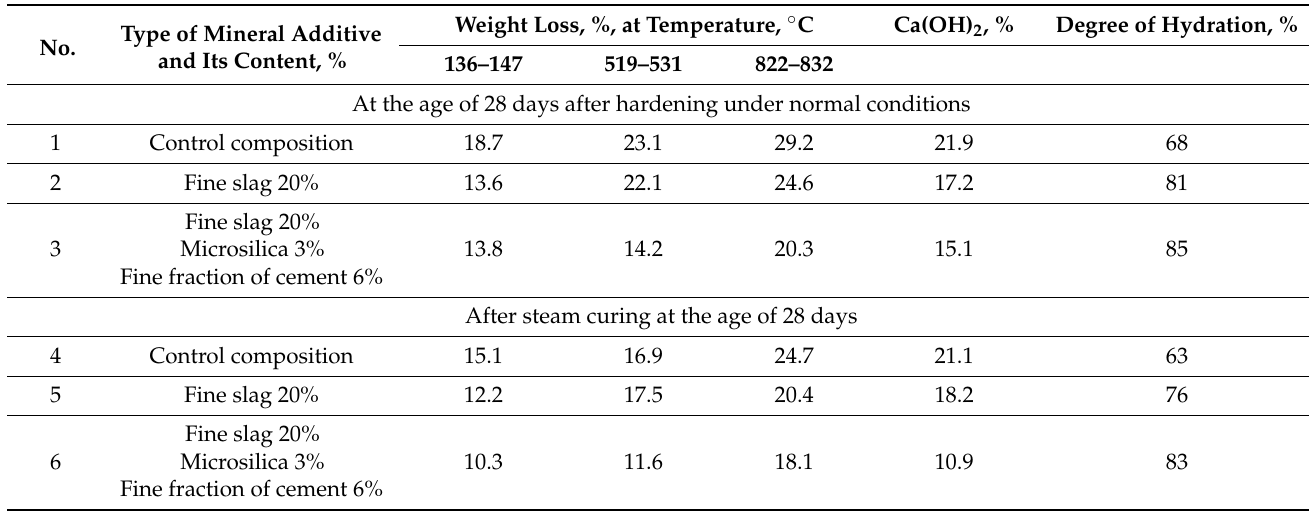
Figure 7. Assumed particle distribution of the clinker component and mineral additives. A is a clinker component; B is a mineral additive; 1 clinker components without mineral additives; 3 optimal dispersion of mineral additives; 2 less than optimal dispersion of mineral additives; 4 less dispersion of large aggregates of mineral additives that of clinker components; 5–8 equal dispersion of particles of clinker component and mineral additives. Table 1. Results of thermographic and radiographic